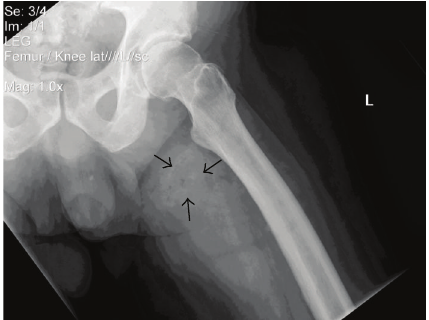
Figure 2: Radiograph of left leg demonstrating gas within the necrotic wound